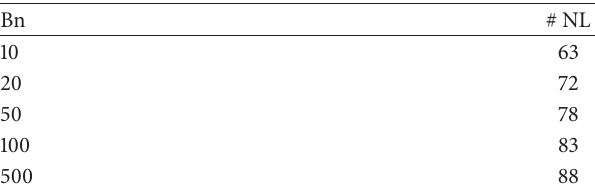
Table 6: The number of nonlinear iterations (level 7) required to reduce nonlinear defect up to 10 −6